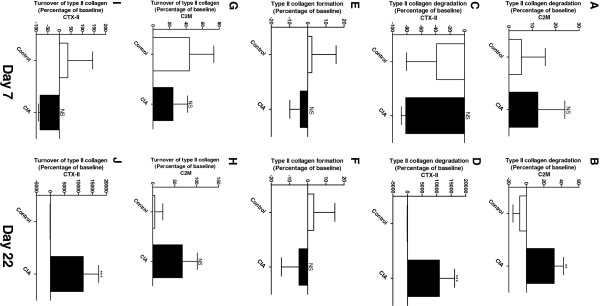
Biomarkers of type II collagen turnover on day 7 and 22 corrected to baseline. A, B: Type II collagen degradation detected with C2M. Range of measurement was [0.3-1.2]. C, D: Type II degradation detected with CTX-II. Range of measurement was [0.2-2132.7]. E + F. Formation of type II collagen detected with P2NP. Range of measurement was [167.3-877.5]. G, H: Calculations of type II collagen turnover with C2M. Range of measurement was [0.0005-0.006]. I + J: Calculation of type II collagen turnover with CTX-II. Range of measurement was [0.3-72.0]. The CIA group (black, n = 10) and control animals (white, n = 10) were compared by Mann Whitney t-test. All statistical analyses were calculated based on baseline corrected values. Data are shown as mean ± SEM and significance levels as *: P < 0.05, **: P < 0.01, ***: P < 0.001.